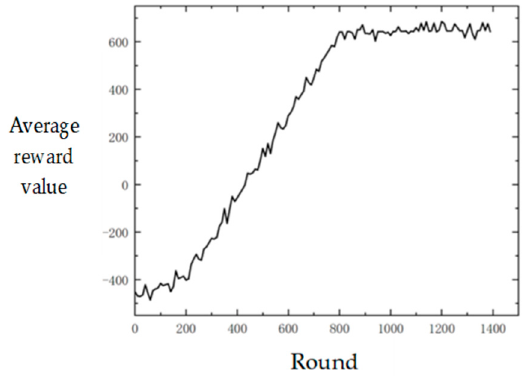
Figure 4. Average reward value.